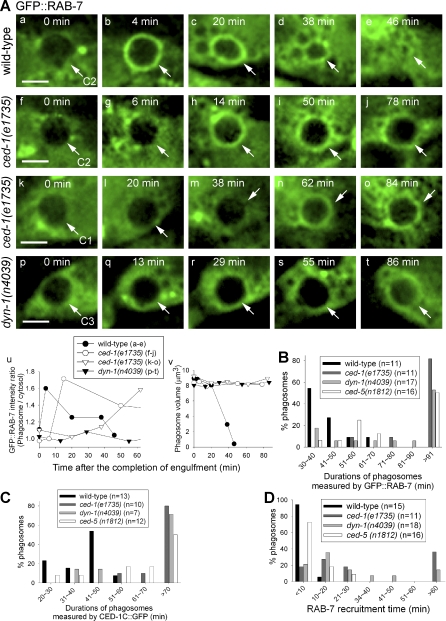

ced-1 and dyn-1 Mutants Are Defective in Recruiting RAB-7 to Phagosome Surface and in the Degradation of Cell Corpses(A) Time-lapse images (a–t) of GFP signal on phagosomal surfaces in developing embryos that express Pced-1 gfp::rab-7. Scale bars indicate 2 μm. Arrows indicate phagosomes. “0 min” represents when engulfment is just complete and phagosomes are detectable as dark holes inside the engulfing cell. Refer to Videos S1, and S5–S7 for the entire time-lapse series of whole-embryo images. (a–e) In a wild-type embryo, the phagosome quickly recruits GFP::RAB-7 and is degraded in normal time course. (f–o) In a ced-1(e1735) embryos, the degradation of both C2 (f–j) and C1 (k–o) phagosomes are severely delayed. C2 and C1 phagosomes are delayed to a different extent in the recruitment of GFP::RAB-7. (p–t) In a dyn-1(n4039) embryo, the C3 phagosome is blocked in both the recruitment of GFP::RAB-7 and degradation of the cell corpse. (u) The GFP::RAB-7 signal intensity ratios (phagosome/cytosol) measured from (a–t) are plotted over time. (v) Phagosome volumes measured from (a–t) are plotted over time.(B and C) Histogram distribution of phagosome durations in embryos using GFP::RAB-7 (B) and CED-1C::GFP (C) as reporters. Duration is measured from the formation of a nascent phagosome (indicated by a dark hole) until its degradation. n, number of phagosomes C1, C2, and C3 measured using time-lapse recording.(D) Histogram distribution of the time that it took to recruit RAB-7 to phagosomes, measured from the formation of a nascent phagosome (dark hole) until the GFP::RAB-7 signal intensity on the phagosomal surface is at least 1.2 fold as high as that in the host cell cytosol. n, number of phagosomes scored.